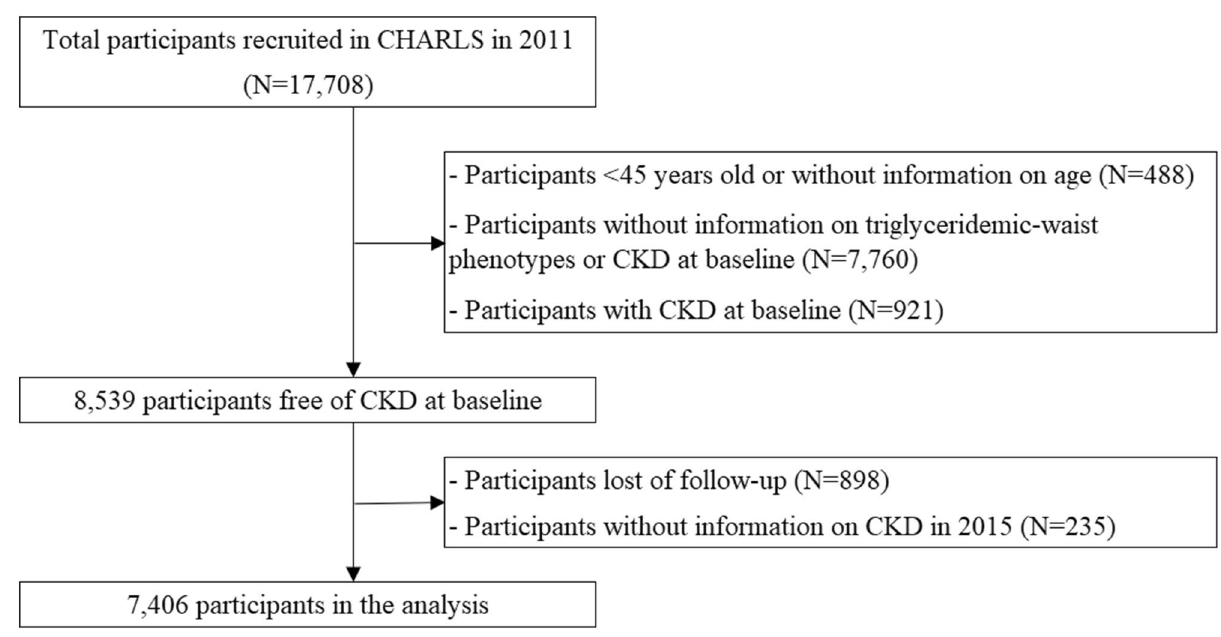
Figure 1. Flow chart of participants selection in